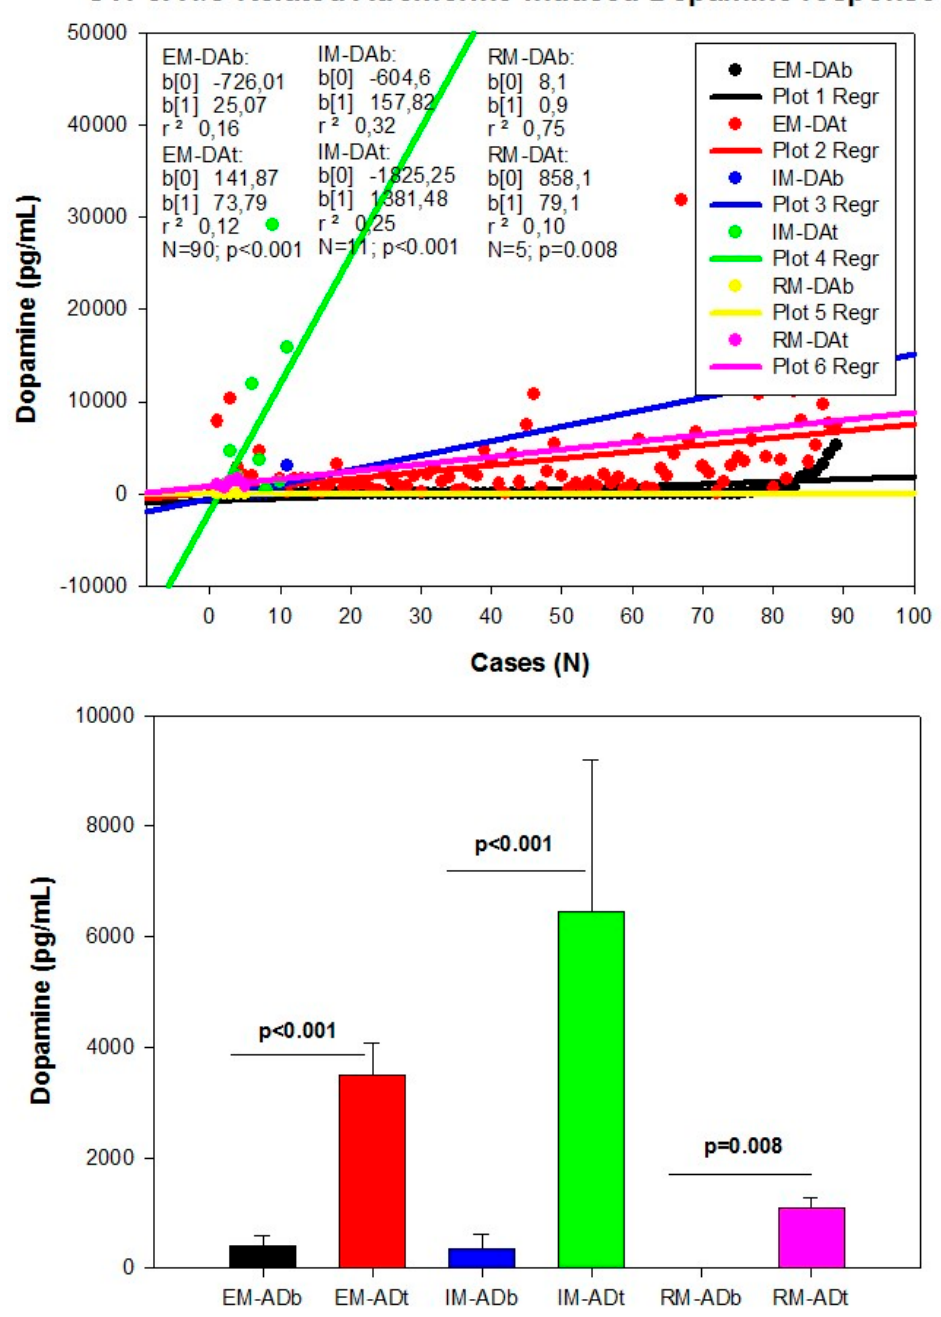
Figure 6. CYP3A4/5-related Atremorine-induced dopamine response. Basal (DAb) and Atremorine- induced dopamine response (DAt) in CYP3A4/5 extensive (EM), intermediate (IM), and rapid metabolizers (RM). Adapted with permission from Cacabelos et al.